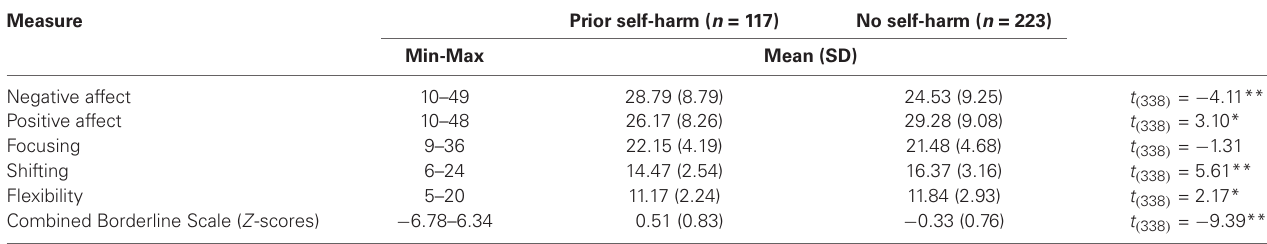
Table 1 | Descriptive statistics for mood, BPD features and attentional subscales .